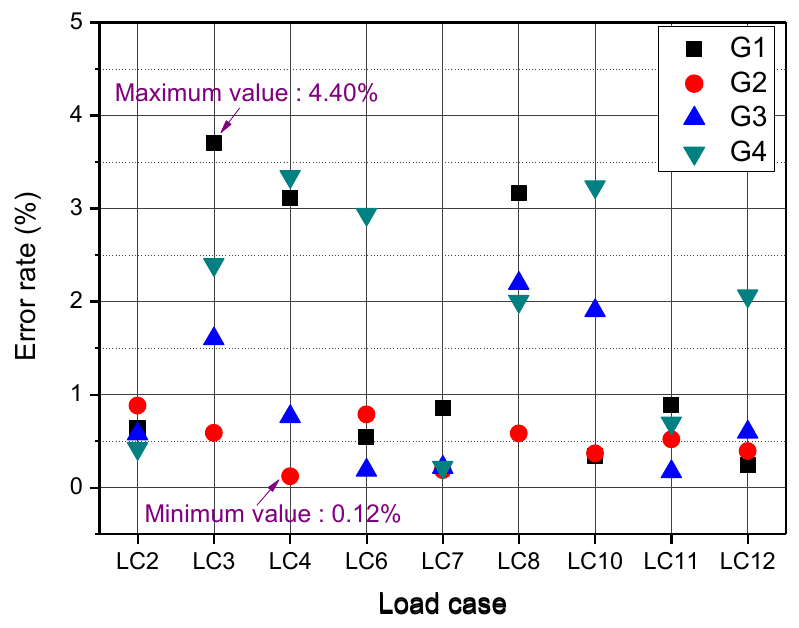
Figure 9. Error rates in each LC.